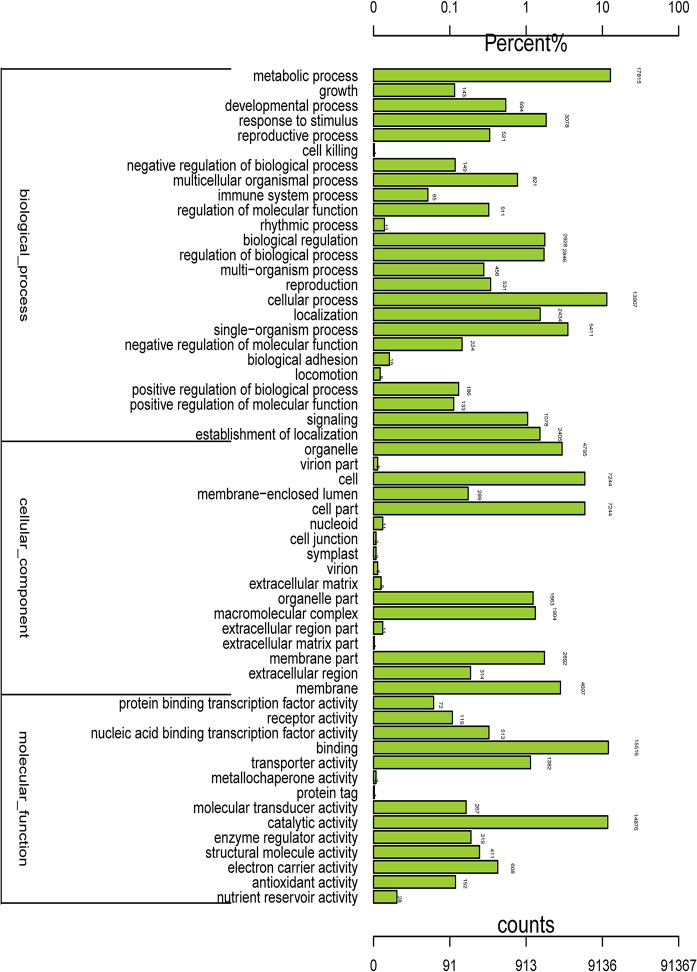
Histogram presentation of Gene Ontology classifications.The results are summarized in three main categories: biological processes, cellular components, and molecular functions. The y-axis on the left side indicates the percentage of genes in a category, and the y-axis on the right side shows the number of genes.